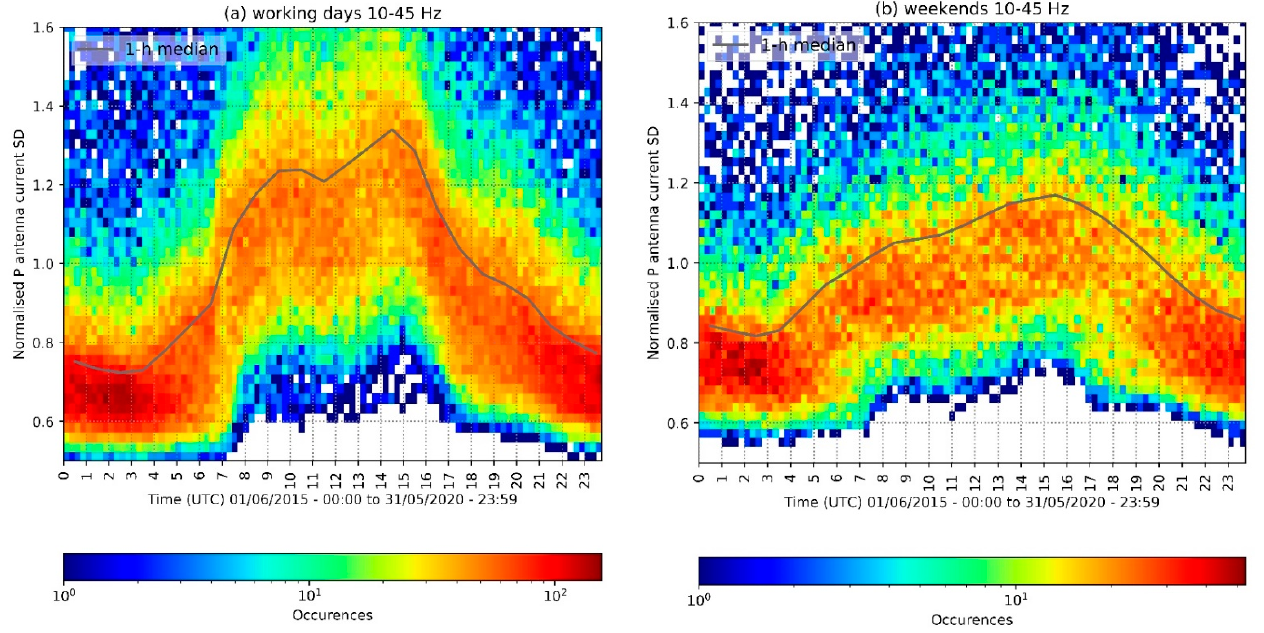
Figure 4. Diurnal variation of the standard deviation of current induced on the antenna in the 10-45 Hz frequency range (1 June 2015-31 May 2020) during ( a ) working days (Mon-Fri) and ( b ) weekends only (Sat-Sun), represented as a 2-D histogram with 15-min temporal resolution (96 bins in each dimension). The solid curve indicates the trend of interpolated hourly median SD values.